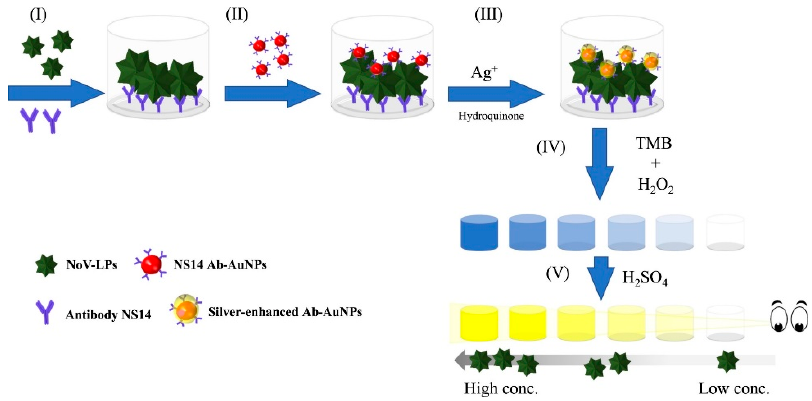
Figure 5. Naked-eye detection of norovirus-like particles (NoV-LPs) by a